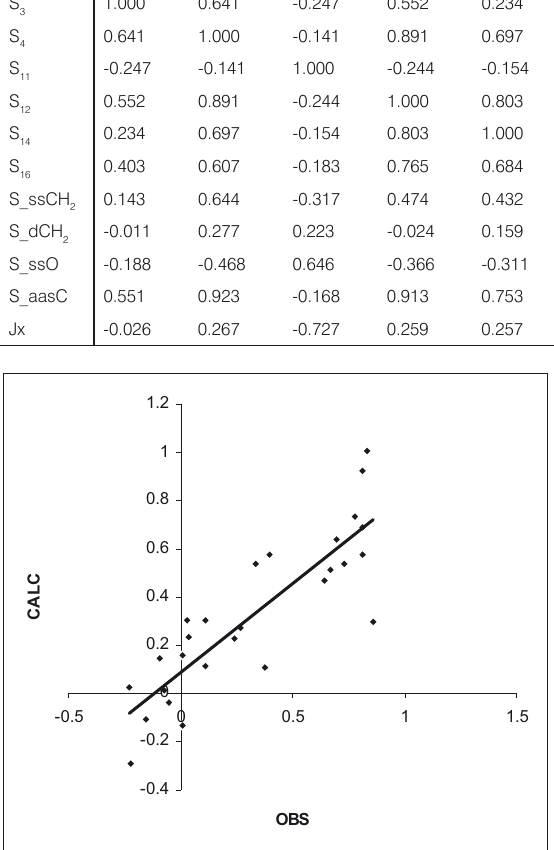
Figure 2. Correlation between observed (% I lipid peroxidation inhibition values according to Eq. (4).